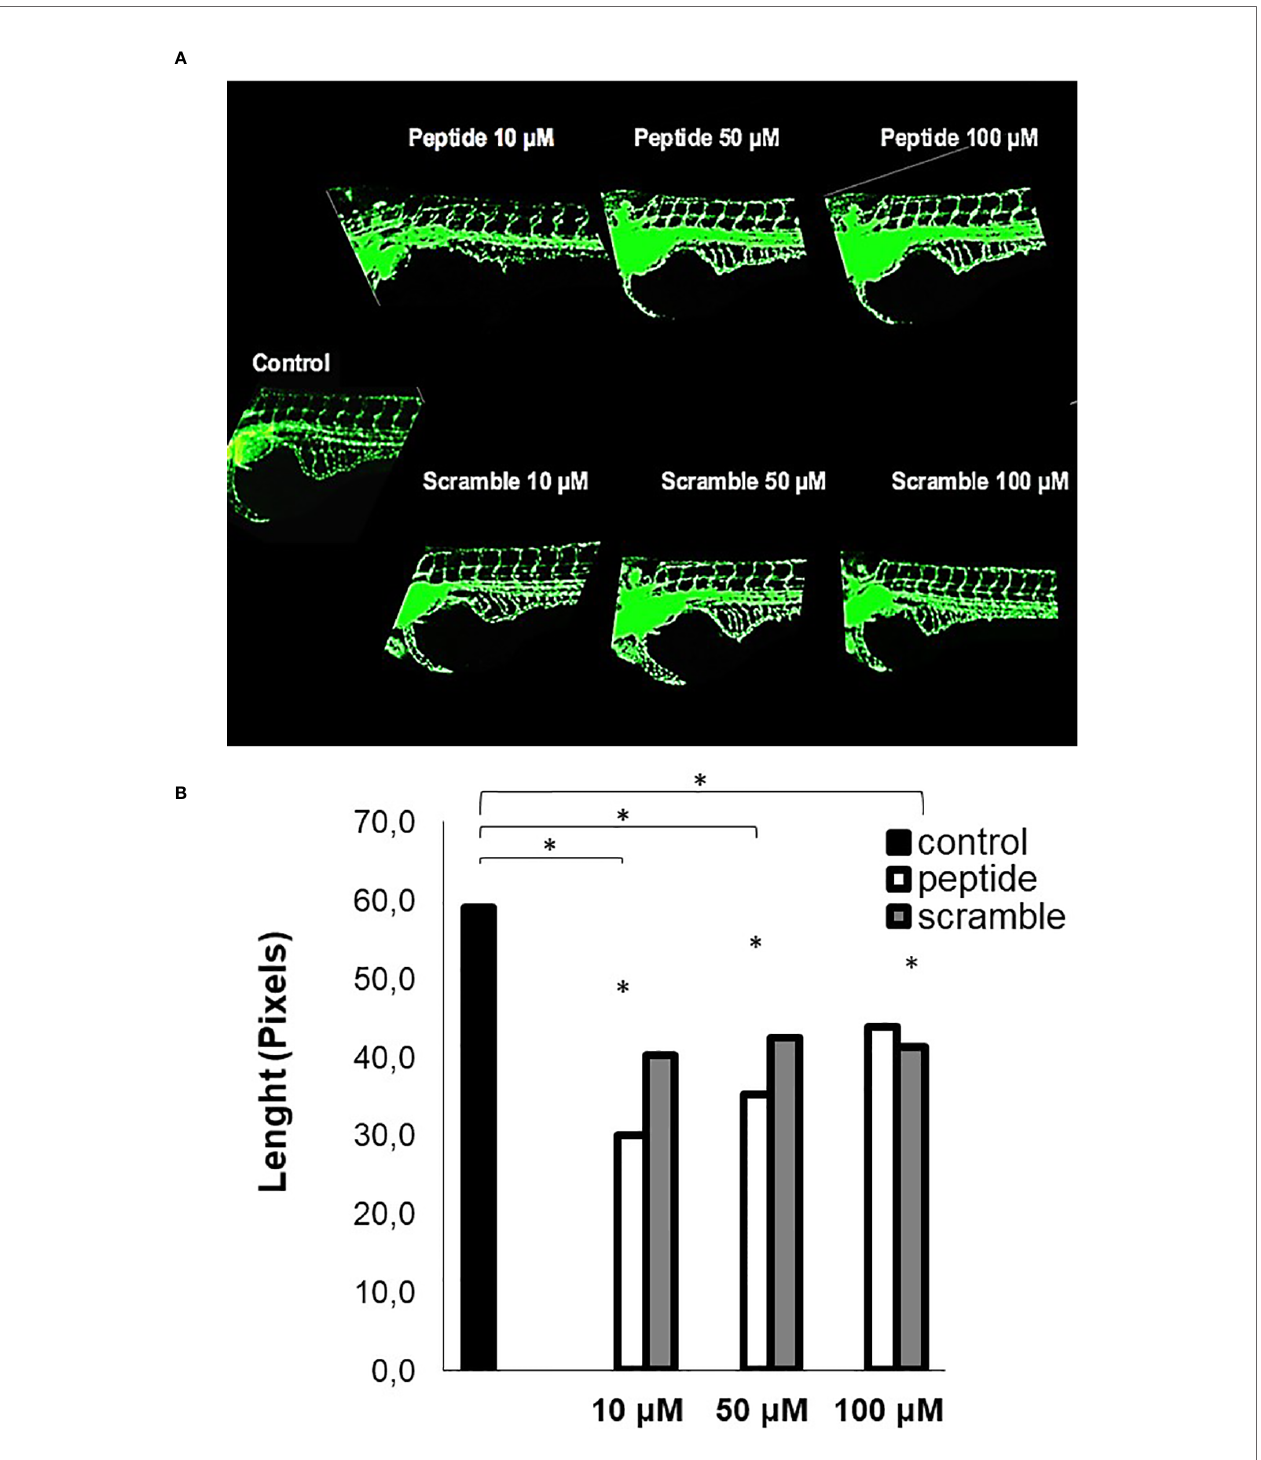
FIGURE 4 | Analysis of angiogenesis in vivo . This assay was performed with Tg [Fli1: eGFP] embryos (10 embryos per group). (A) the image of zebra fi sh embryos. Control, untreated embryos. Peptide, embryos treated with the HS-binding peptide. Scramble, embryos treated with scrambled peptide. Assays were performed with zebra fi sh embryos 2 days after fertilization (2 dpf). After 24 hours of treatment, the animals were analyzed by confocal microscopy and the images obtained in 10X magni fi cation. Subintestinal vessels were analyzed. (B) the quanti fi cation of the subintestinal vessels was evaluated using ImageJ software. The values express the mean and standard deviation in each group. *p < 0.05 (ANOVA). The HS-binding peptide was capable of inhibiting angiogenesis of sub intestinal